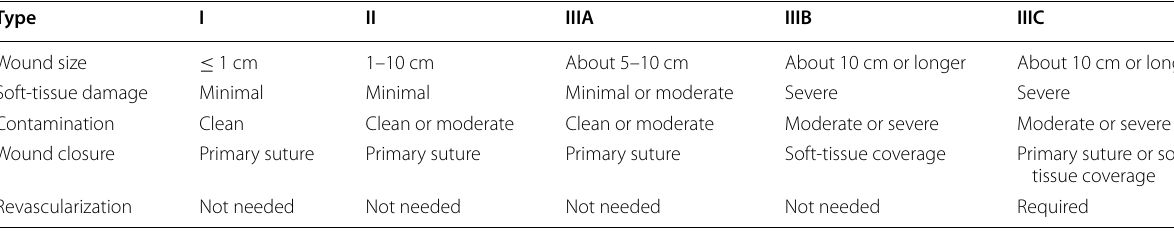
Table 1 Modified Gustilo–Anderson classification